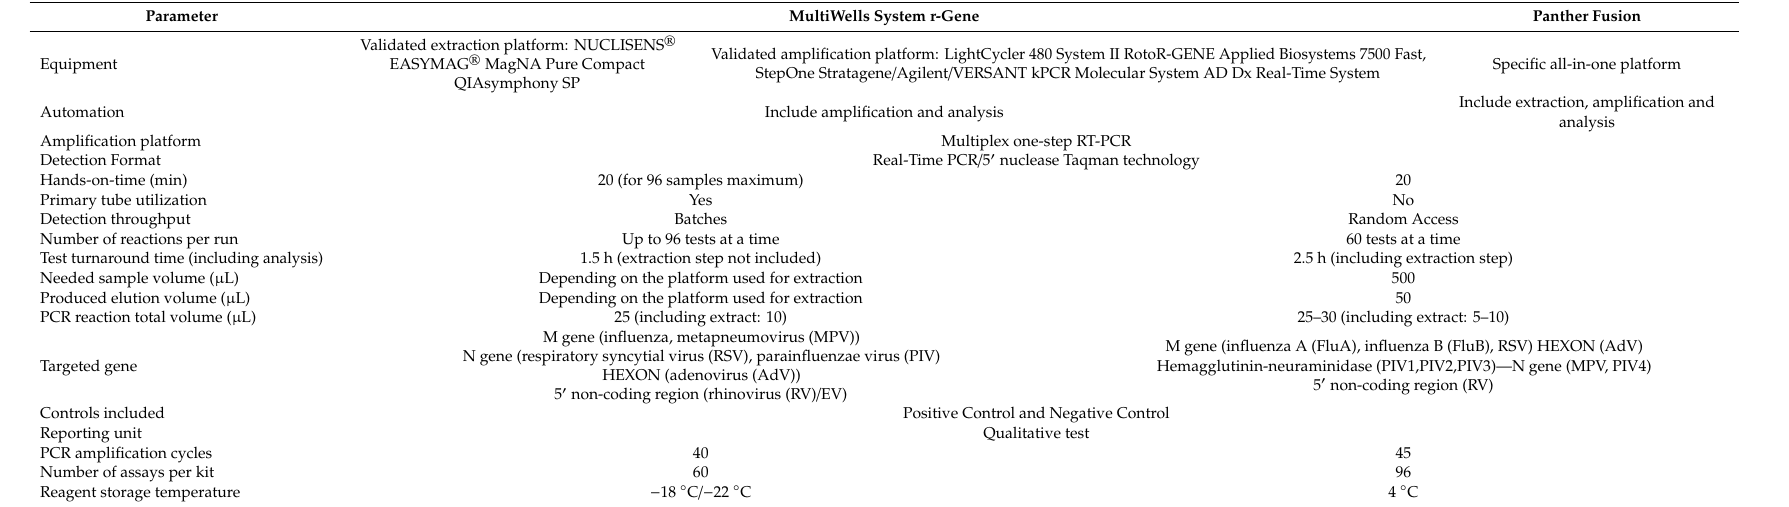
Table 1. Main characteristics of compared